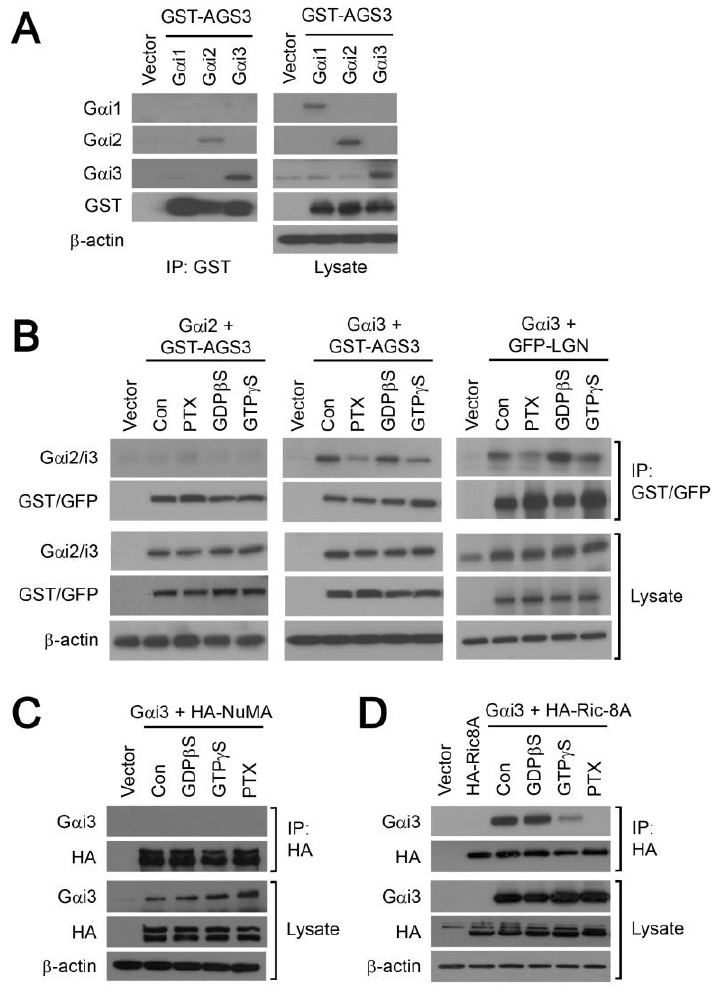
Figure 4. Interaction of G α i with components of the spindle orientation complex in HEK293 cells. ( A ) HEK293 cells were transiently transfected with vector (pcDNA3.1), or co-transfected with GST-tagged AGS3 and G α i1 , G α i2 or G α i3 . Samples were incubated with anti-GST and then immunoprecipitated using protein G agarose. Presence of G α i1 , G α i2 , G α i3 and GST-tagged AGS3 were analyzed by Western blotting with specific antisera. ( B ) HEK293 cells were transiently transfected with vector (pcDNA3.1), or co-transfected with GST-tagged AGS3 or GFP tagged LGN and G α i2 or G α i3 . One day after transfection, cells was treated with or without pertussis toxin (PTX) for 16 h. Cell lysates were subjected to treatment with GDP β S and GTP γ S (100 µ M; 6 h at 4 ◦ C). Samples were subjected to immunoprecipitation with either anti-GST or anti-GFP antisera and protein G agarose. G α i subunits in the immunoprecipitates were detected by Western blot analysis. ( C ) HEK293 cells transiently co-expressing HA-tagged NuMA and G α i3 were subjected to co-immunoprecipitation with anti-HA agarose and Western blotting as in B . ( D ) HEK293 cells were treated as in C except that HA-tagged Ric-8A was transfected and probed instead of HA-tagged